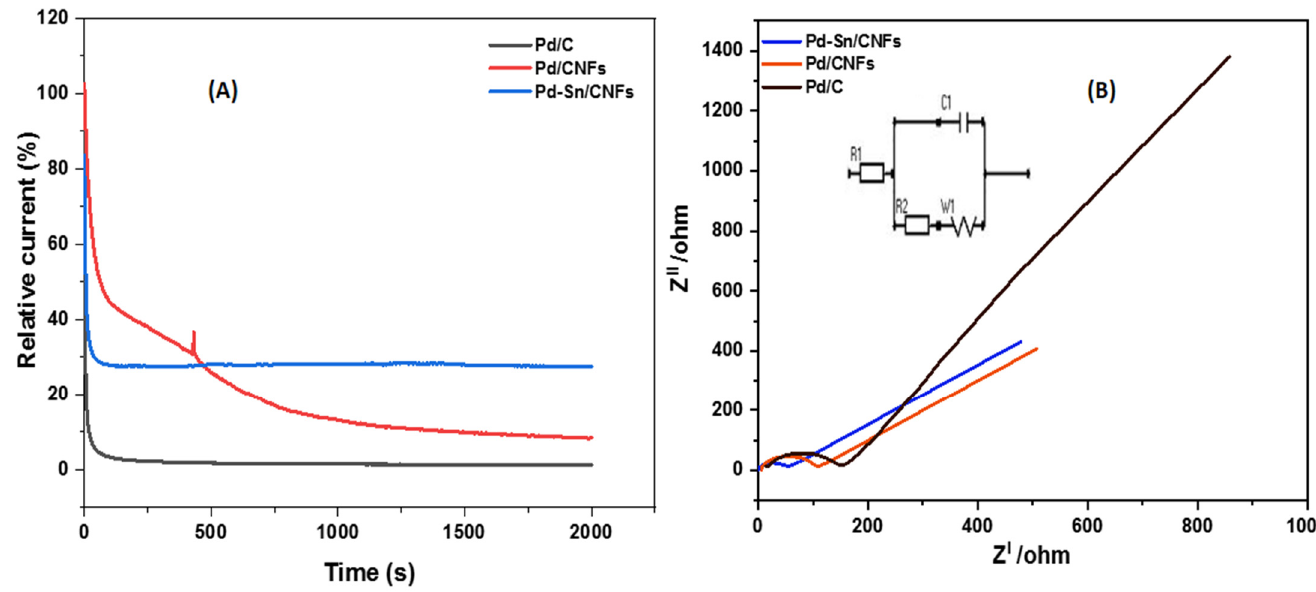
Figure 9. Chronoamperometric curves ( A ) and Nyquist plots of impedance spectra with corresponding equivalent circuit ( B ) of Pd/C, Pd/CNFs and Pd-Sn/CNFs electro-catalysts at 0.5 V in 1 M KOH + 1 M CH 3 OH solution.